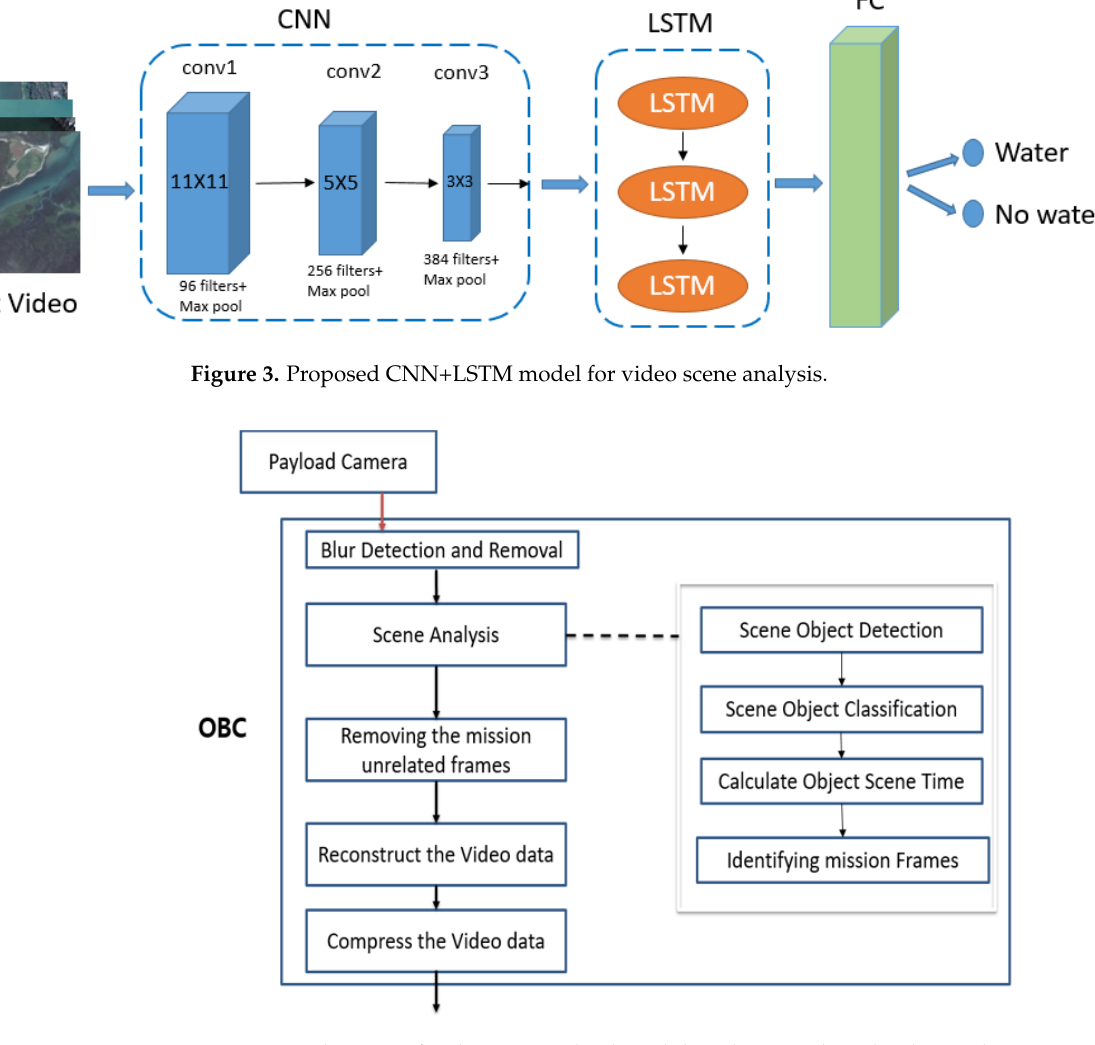
Figure 4. Architecture for the proposed onboard deep-learning-based video analysis.